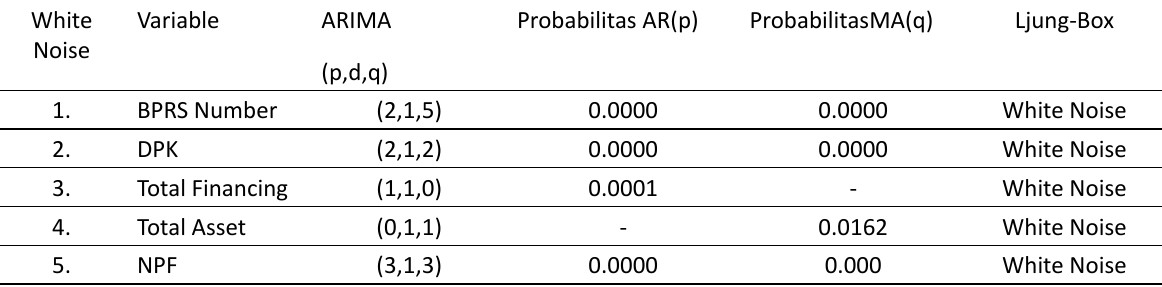
Table 5: Hasil Uji